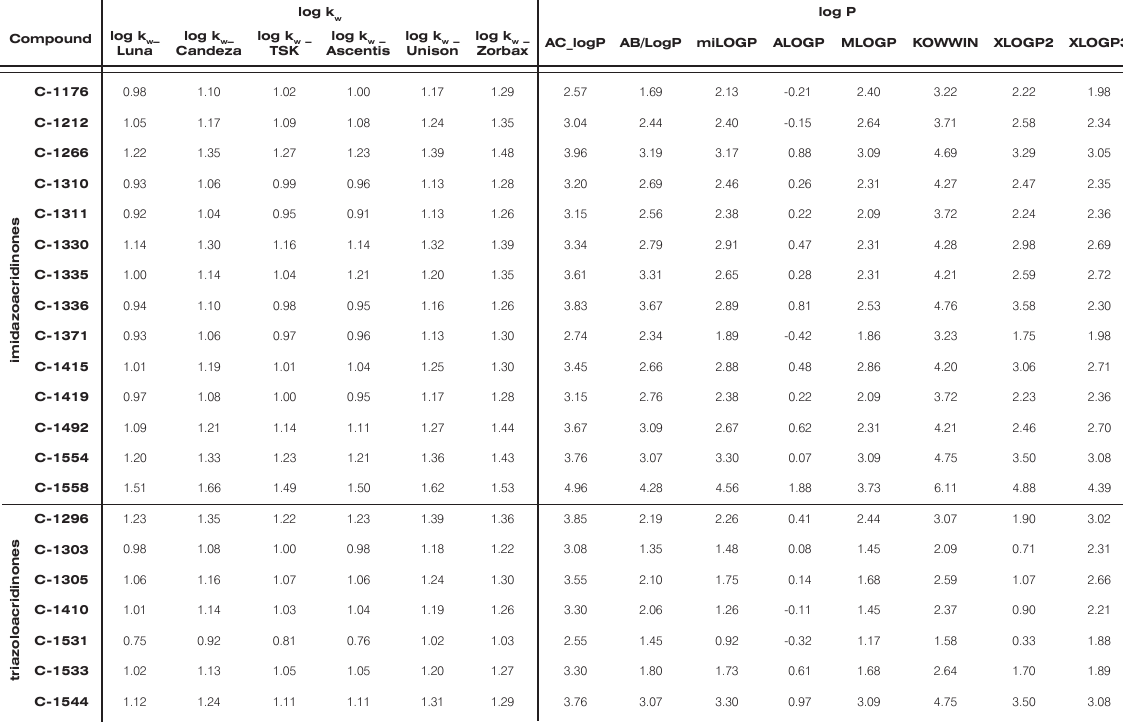
) with calculated lipophilicities (log P) of studied acridinones. w log k